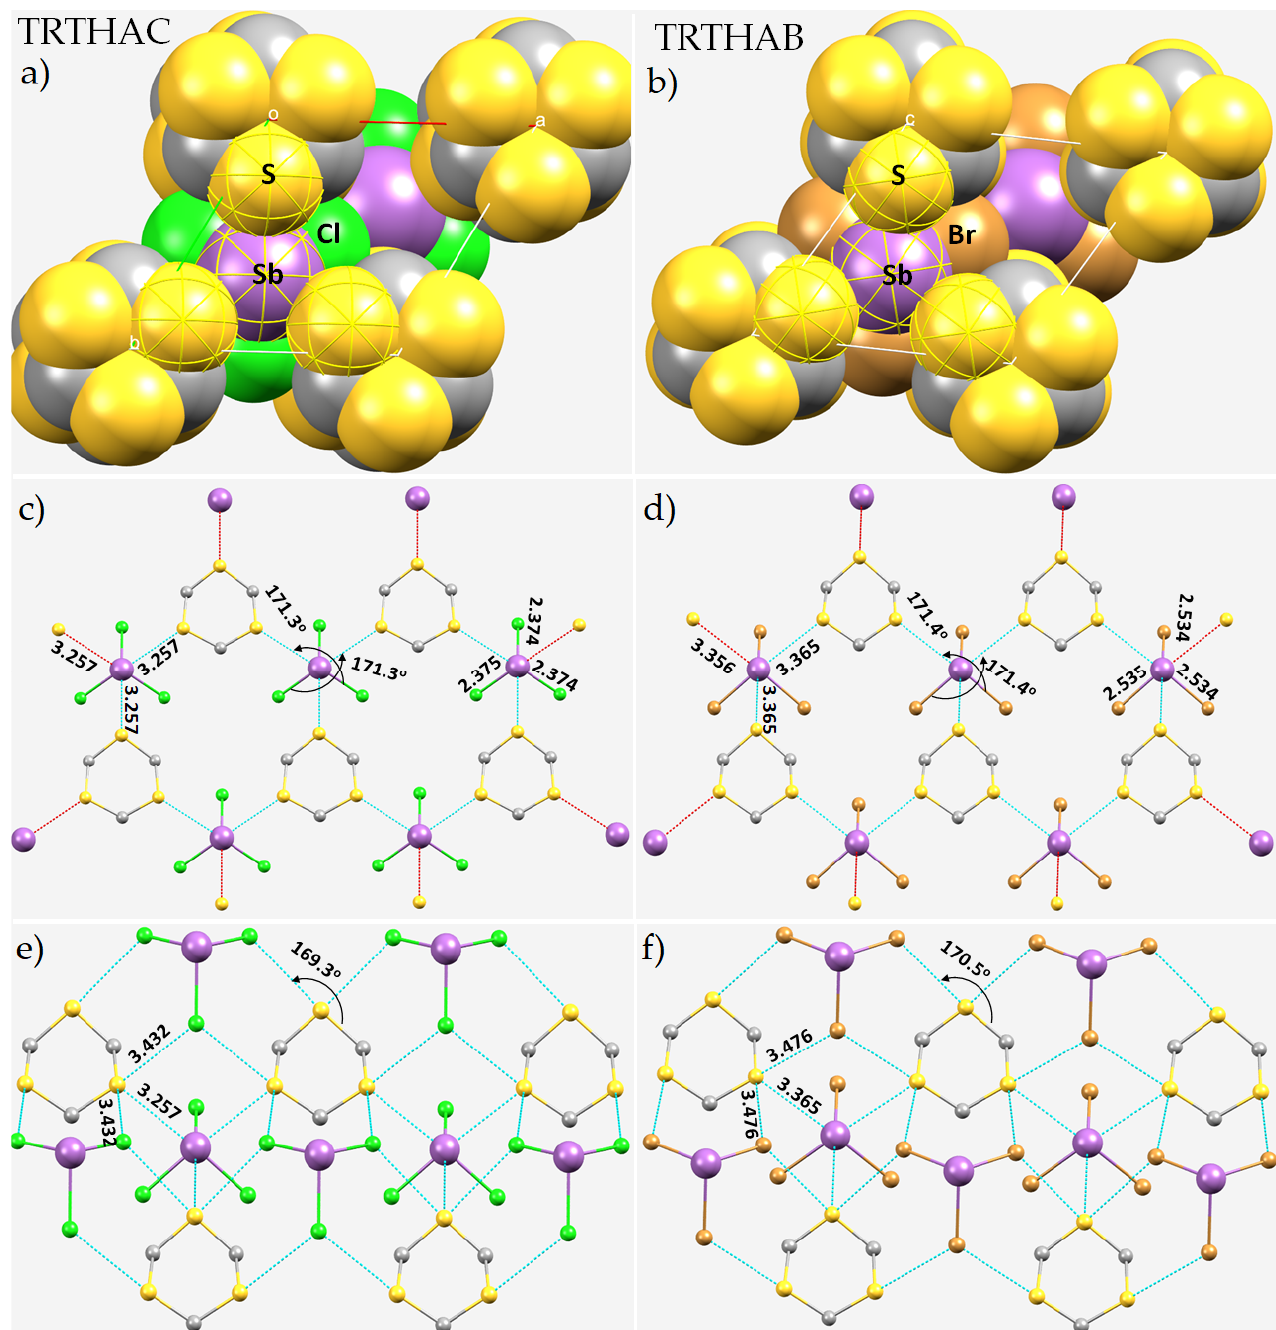
Figure 19. Space-filling models showing the molecular packing in the crystals of ( a ) SbCl 3 ·(CH 2 S) 3 (CSD ref. code in capital letters) and ( b ) SbBr 3 ·(CH 2 S) 3 (CSD ref. code TRTHAB). Illustration of the exceptionally long Sb···S intermolecular distances and their angular features is shown in ( c , d ), respectively. Included in ( e , f ) are the μ 3 -bridges of covalently bound S, leading to the emergence of Type-IIa chalcogen bonding in SbCl 3 ·(CH 2 S) 3 and SbBr 3 ·(CH 2 S) 3 crystals, respectively. Atom types are labeled in each case. Atoms are shown as small spheres and bonds as lines in atom color, whereas the intermolecular interactions are represented by dotted lines in cyan. Bond distances and bond angles are in Å and degree, respectively.